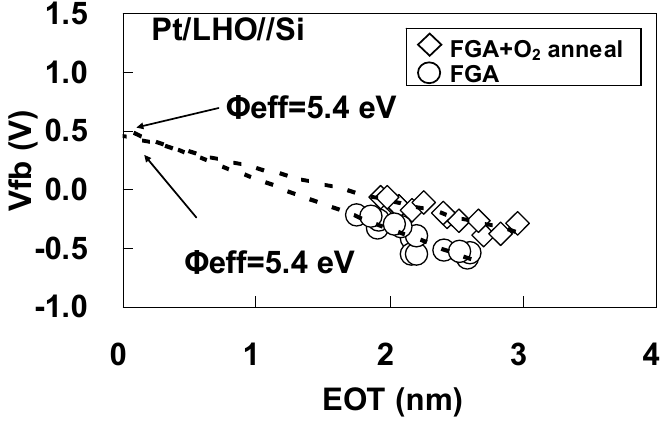
Figure 27. Dependence of Vfb on EOT for the specimens after FGA only and after annealing. φ eff was estimated from the point of intersection of the Y axis additional O 2 with the extrapolated experimental data by assuming that a fixed charge was responsible for the local slope of the plot at the interface between LHO and the Si